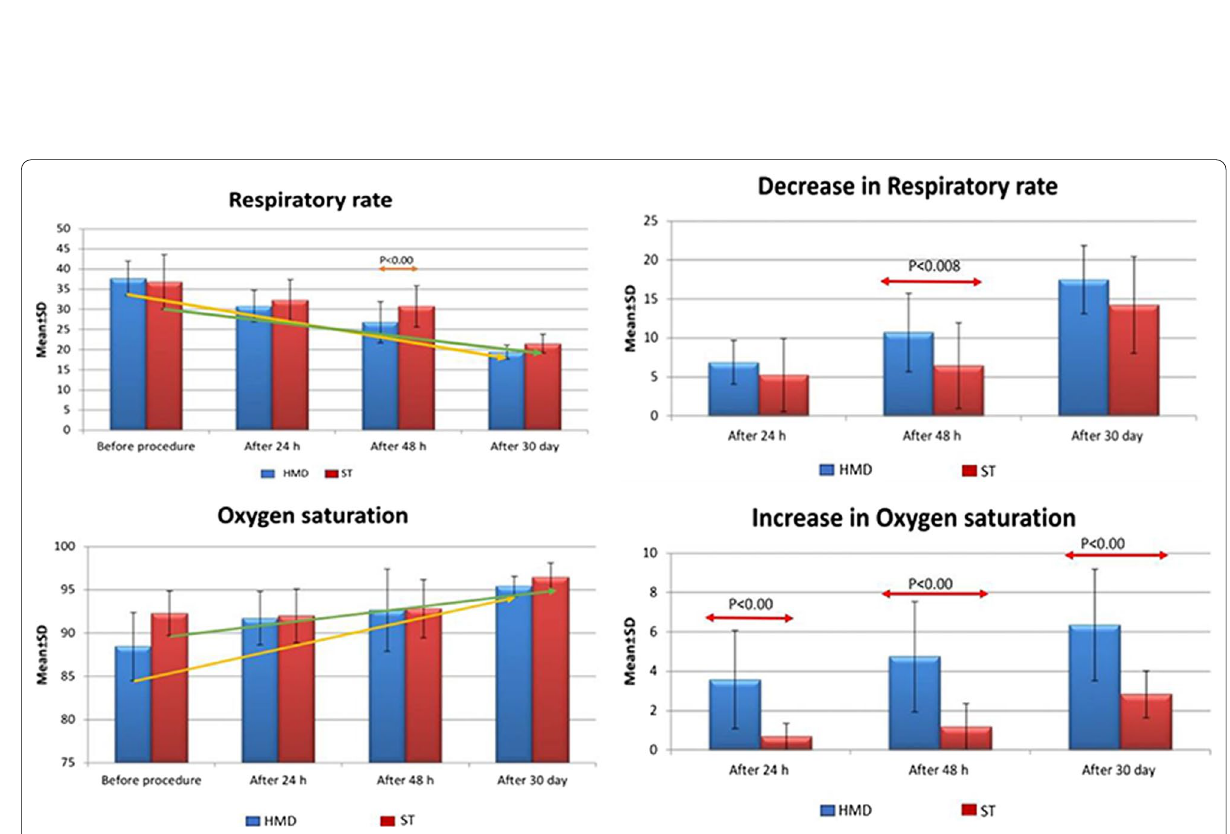
Fig. 4 Rate of change in respiratory rate and oxygen saturation between study groups at admission and during